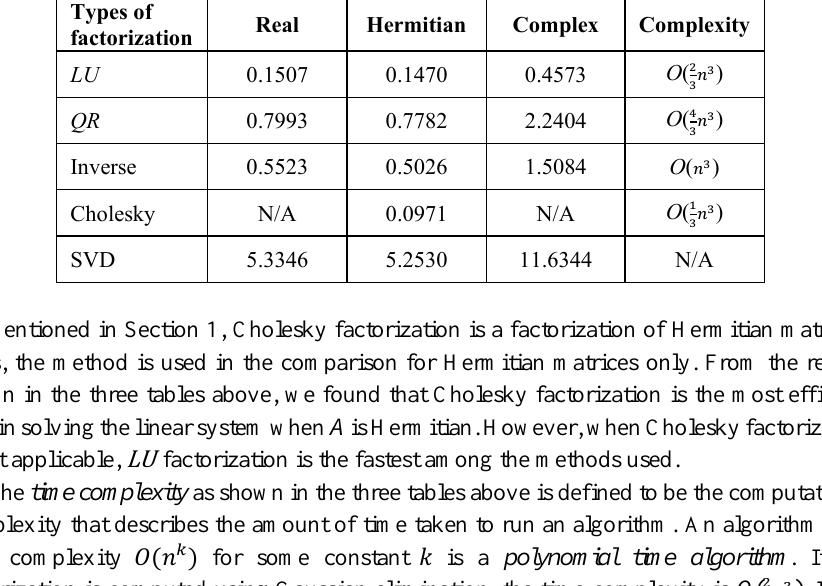
Table 3. Computation time (in second) when 𝑛 is 2000